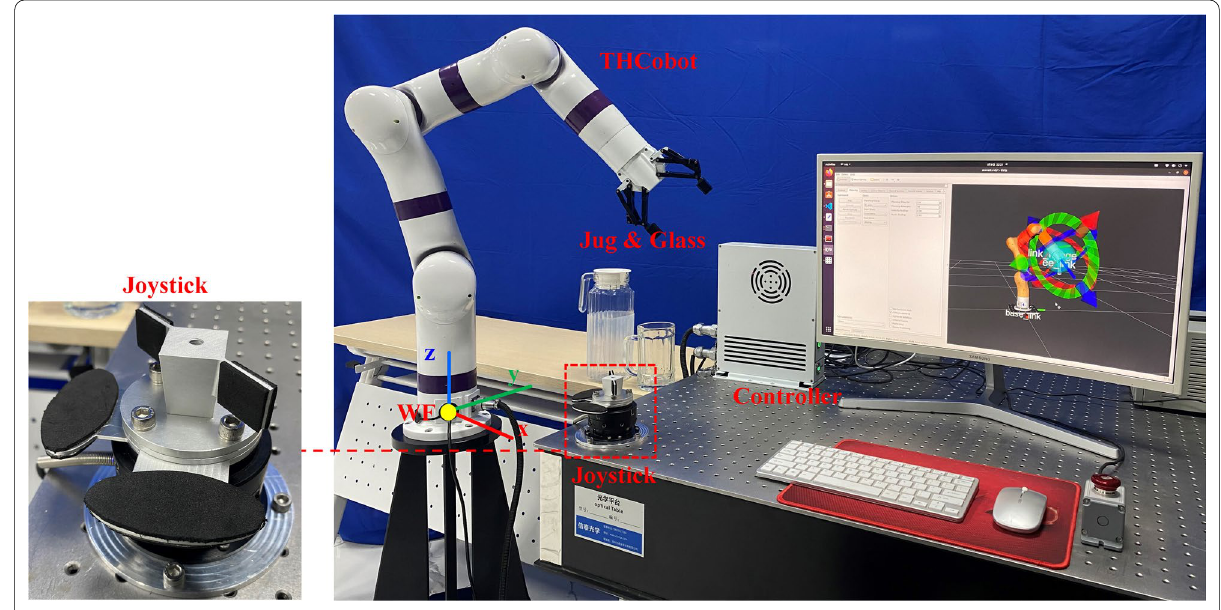
Figure 6 Experiment